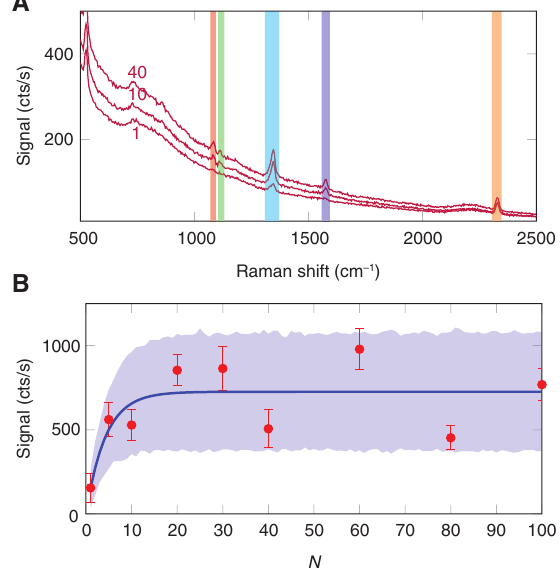
Figure 2: Waveguide-excited SERS signals for varying number of antennas. (A) Backscattered Raman spectra of a waveguide covered with N = 1, 10 and 40 antennas. The red (1080 cm −1 ), green (1110 cm −1 ), cyan (1340 cm −1 ), and blue (1575 cm −1 ) lines correspond to pNTP peaks [24], while the orange peak (2330 cm −1 ) is associated to the SiN [18]. (B) Backscattered SERS signal of the 1340 cm −1 peak as a function of N . The solid blue line represents a fit to the ideal model, while the shaded area represents the signal counts probability distribution due to differences in antenna conversion efficiency or